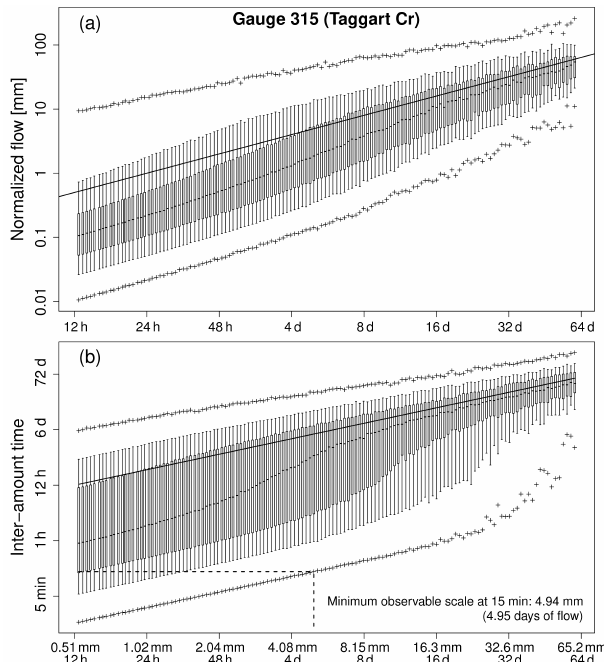
Figure 8. Quantile plots of flows (a) and inter-amount times (b) for Taggart Creek for a range of scales, from 12h to 60 days. The bold black line denotes the mean values. The dotted black line shows me- dian values. The central part of box plots represents the 25–75 per- centile range, upper and lower whiskers the 10–90 percentile range, crosses the 1–99 percentile